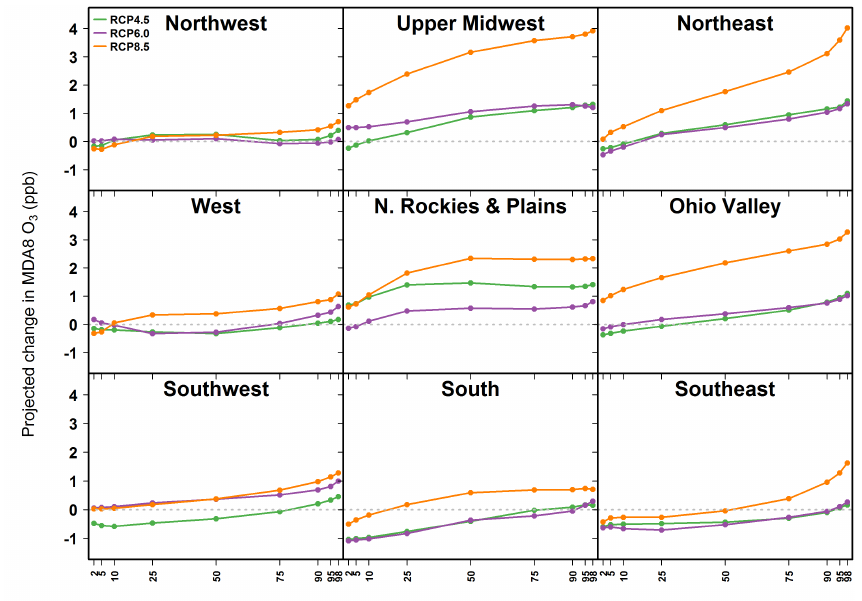
Figure 5. Projected changes in percentiles of summer average MDA8 O 3 mixing ratios (ppb) simulated by CMAQ under RCP4.5, RCP6.0, and RCP8.5 within each of the US climate regions shown in Fig. 1.